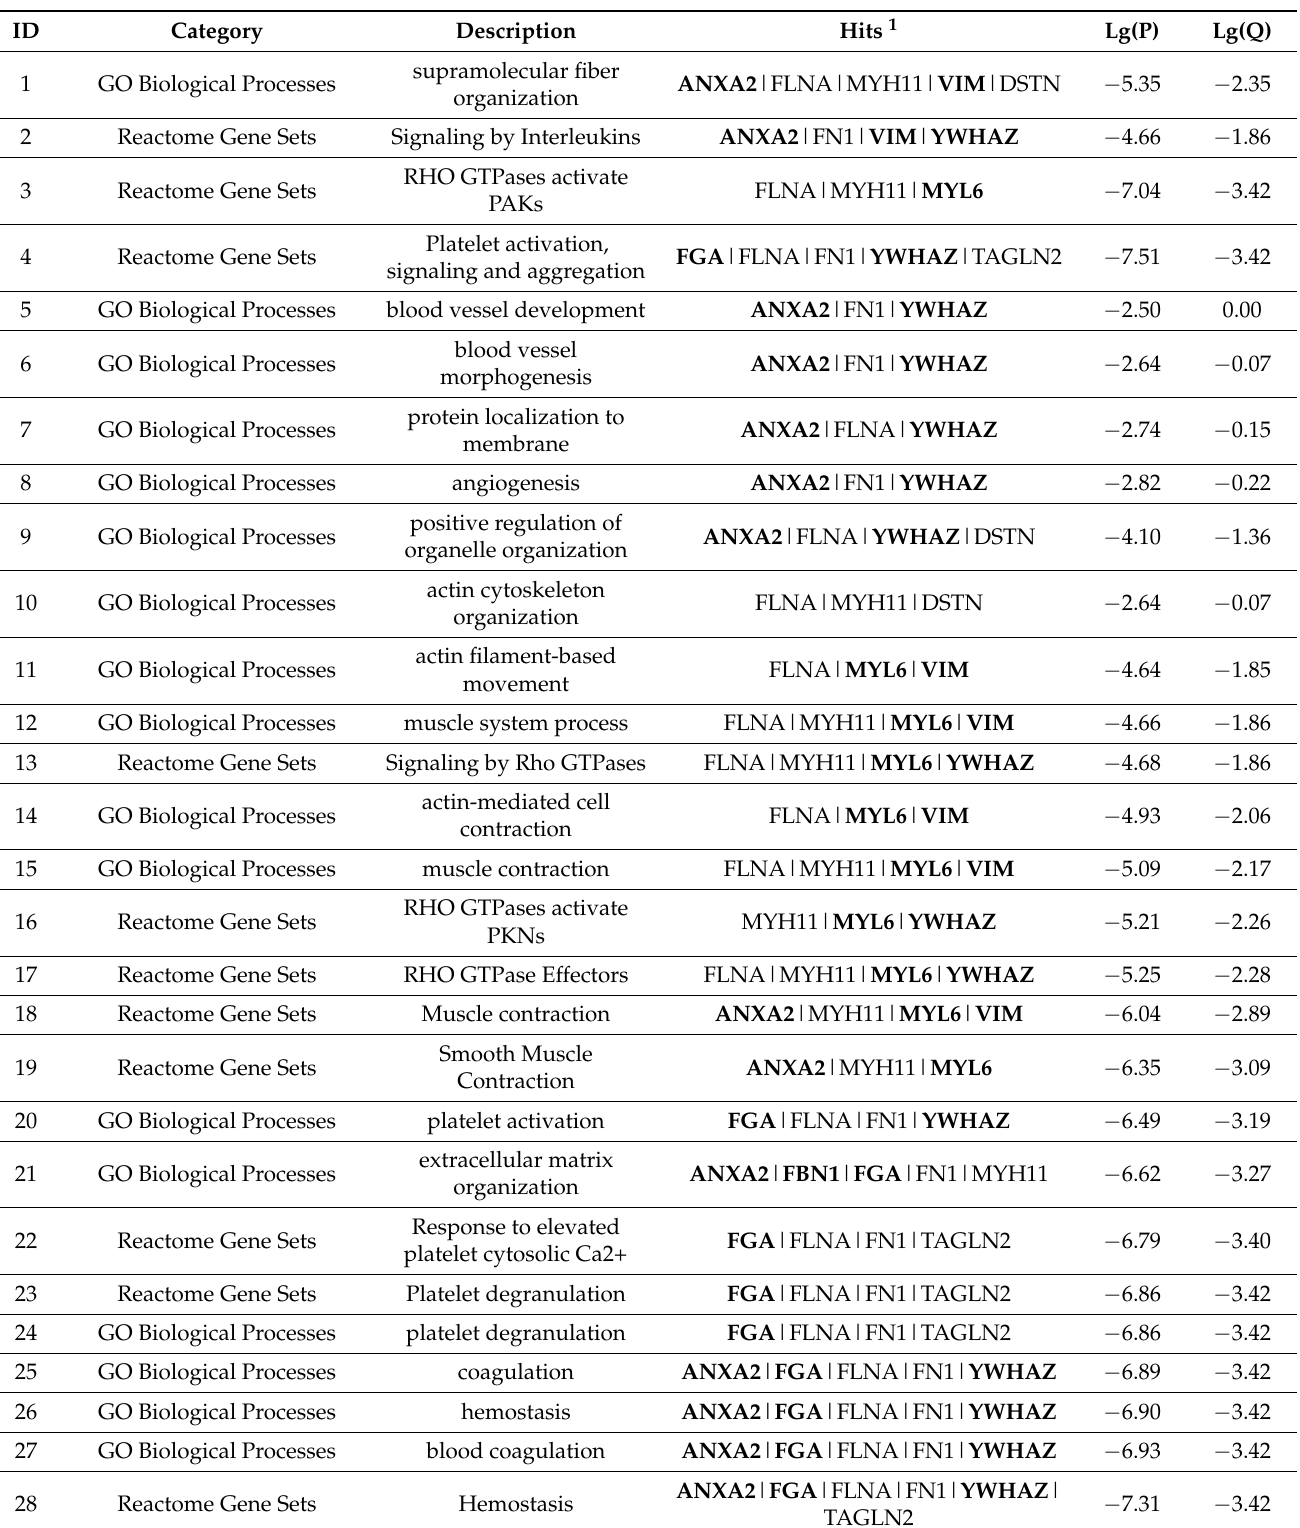
Table 5. Metascape Enrichment